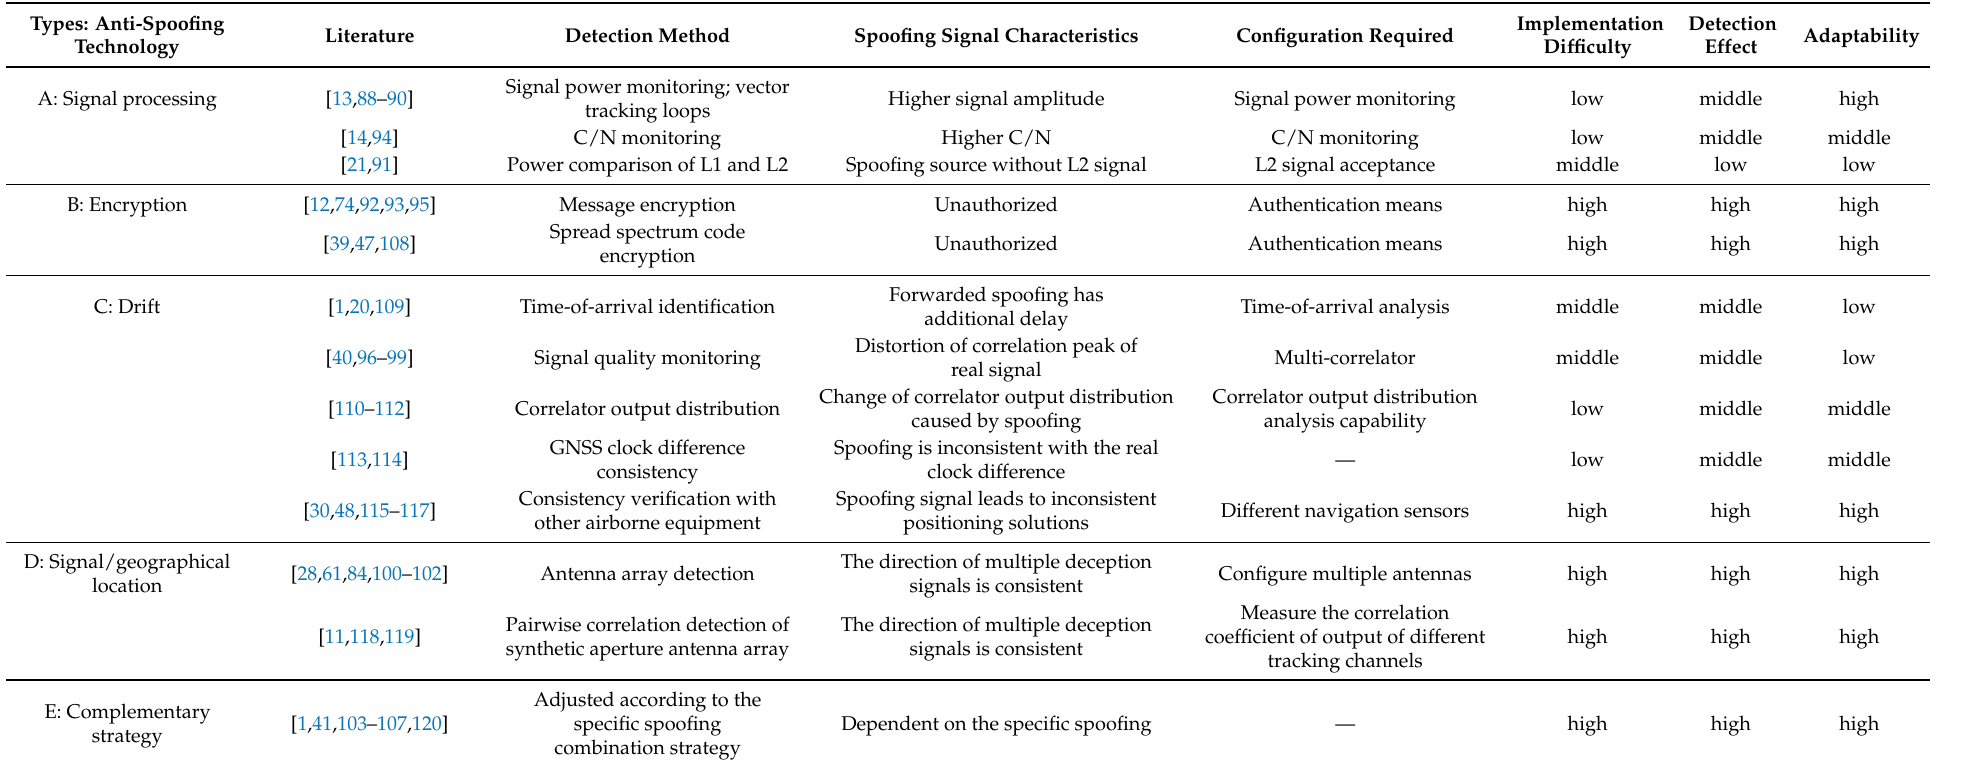
Table 4. Comparison and literature summary of anti-spoofing technology under